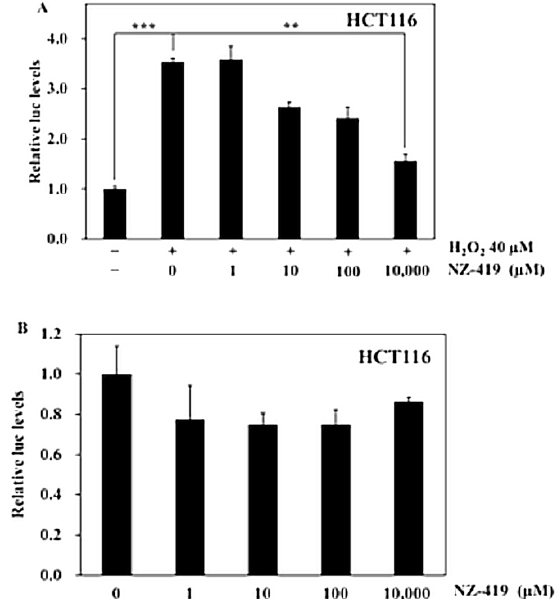
Figure 2. NZ-419 suppresses H 2 O 2 -induced Nrf2 promoter transcriptional activity. HCT116 cells were treated with NZ-419 (10,000 µ M) and incubated for 30 min at 37 ◦ C. After incubation, cells were treated with 40 µ M H 2 O 2 for 24 h ( A ), or for 24 h without H 2 O 2 . ( B ) The basal luciferase activity level of the control was set as 1.0. The data are presented as the means ± SD ( n = 3). ** p < 0.01, *** p < 0.005 vs. 0 control. The data are representative data obtained from more than three independent experiments.